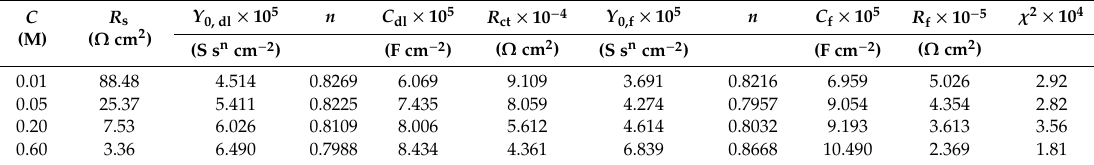
Table 3. Fitted impedance parameters for galena in NaCl solutions with di ff erent concentrations.